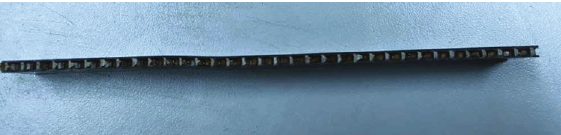
Figure 13: Unloading section of